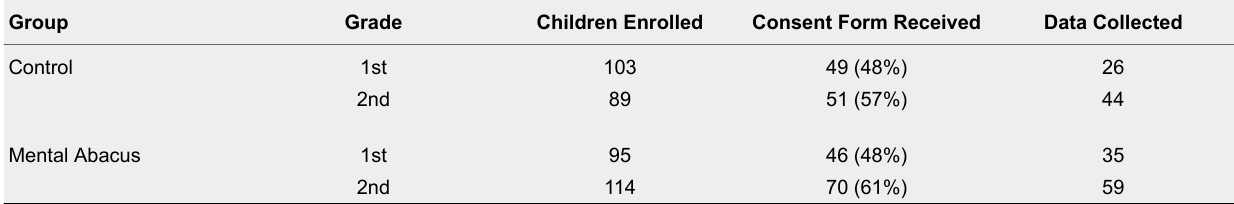
Participants in the Study Group